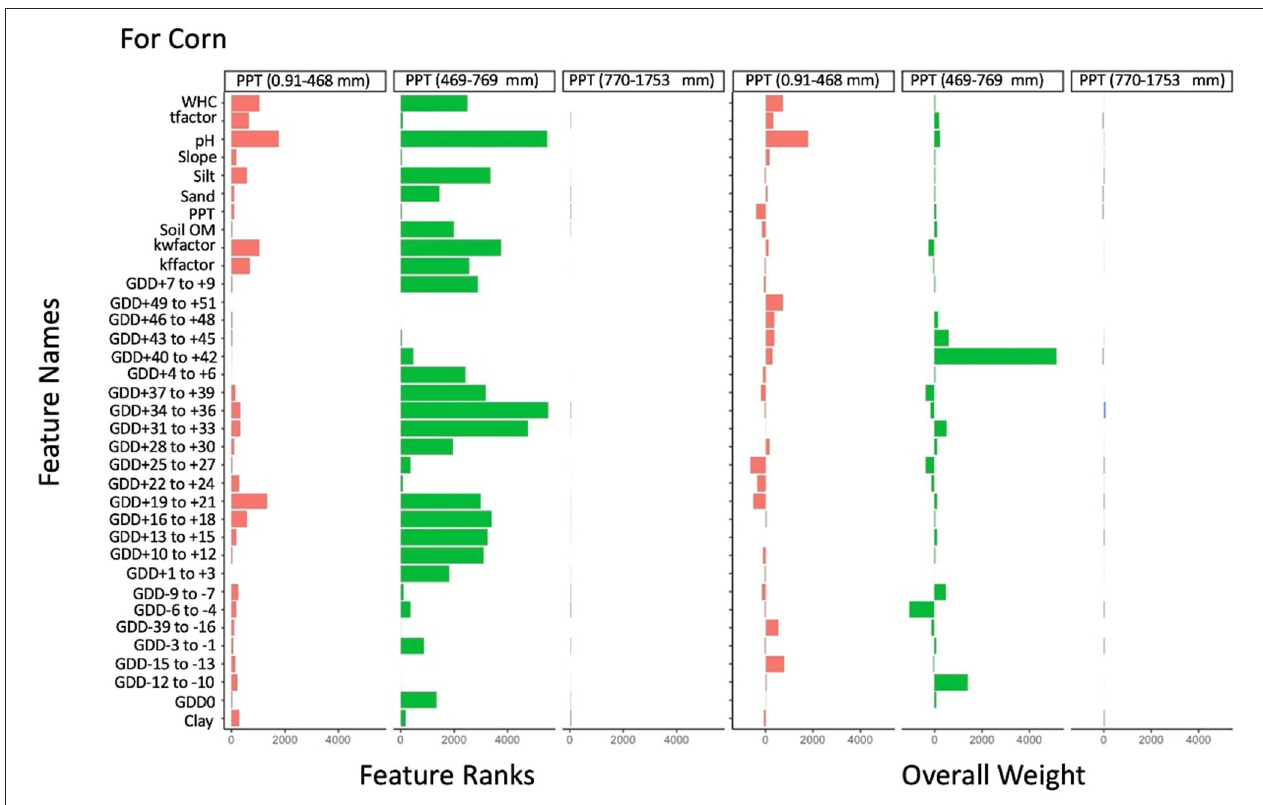
FIGURE 6 | Feature ranks and overall weight of features following explainable machine learning interpretations for corn for low, medium, and high quartiles of